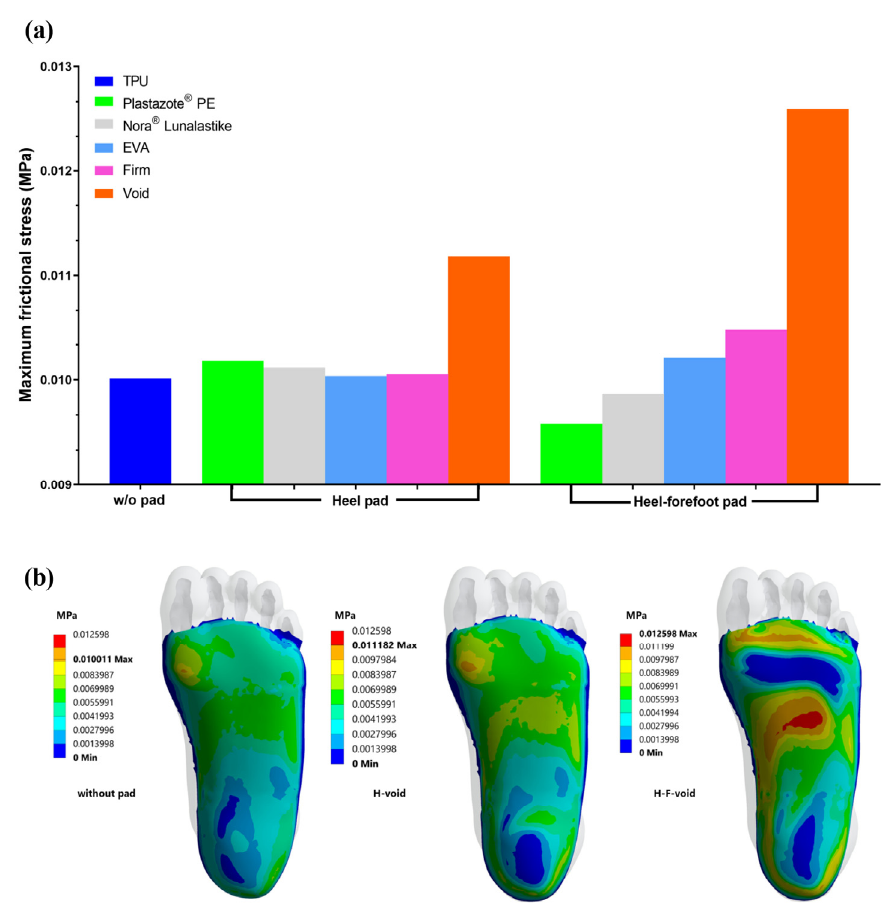
Figure 3. ( a ) The maximum frictional stress obtained for CMI with pad materials ranging from soft to hard compared with CMI without pad; ( b ) frictional stress distribution with the highest maximum frictional stress, especially with a heel void (H-void) and a heel–forefoot void (H-F-void) compared with CMI without pad.